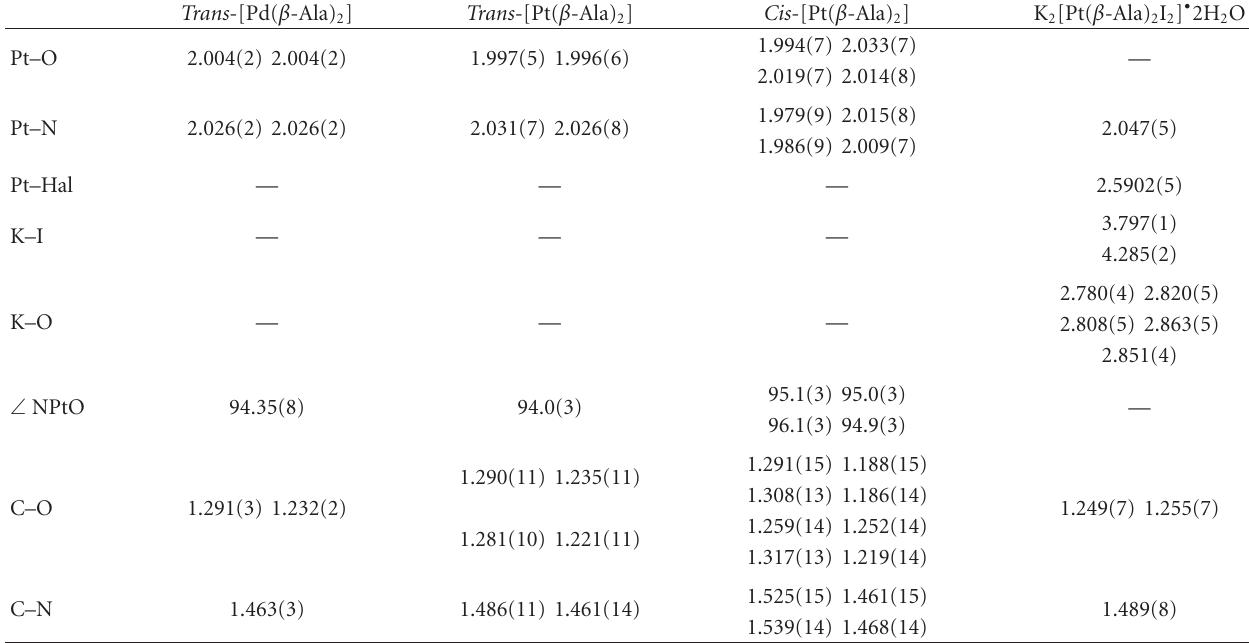
Table 3: Selected stereochemical data for the studied